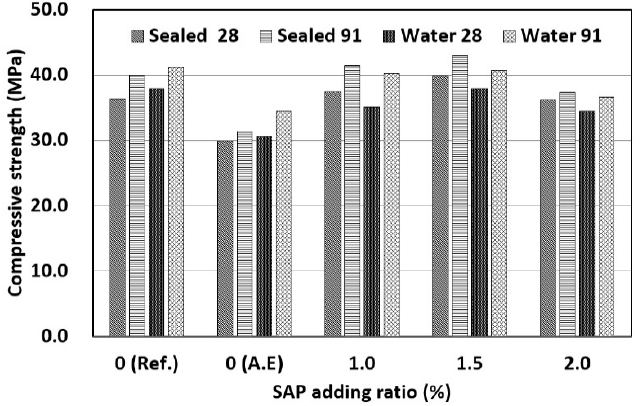
Figure 8. Results of compressive strength (W/C 40%).